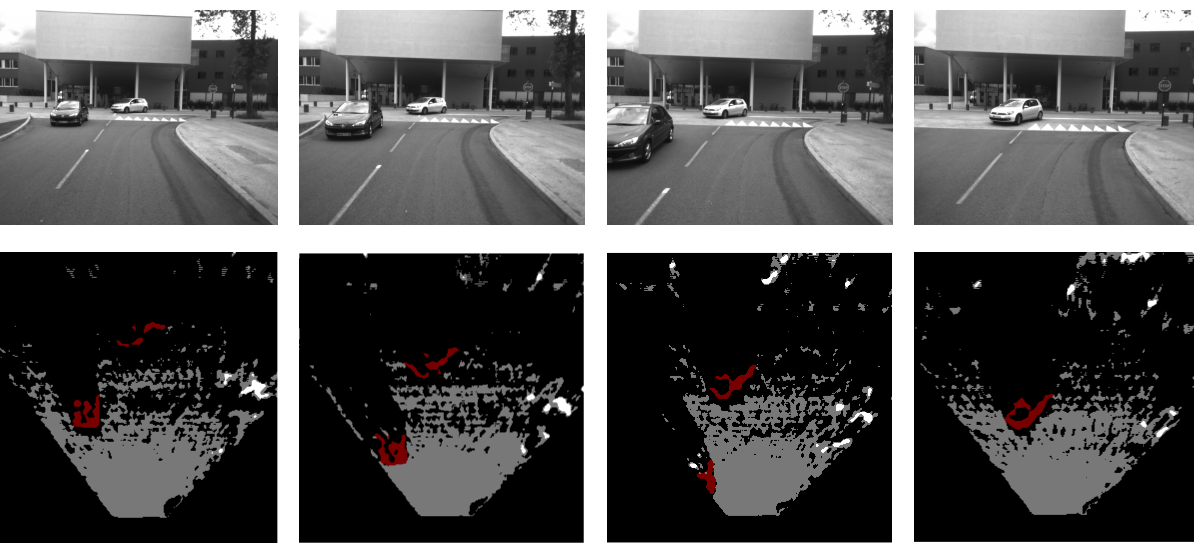
Figure 11. More experimental results of the dynamic occupancy grid map: independent moving objects (red), static occluded areas (white), free areas (gray) and undetected areas (black).